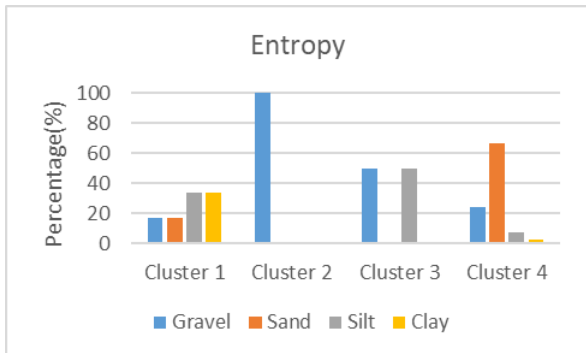
Figure 8: Per cluster sediment composition percentage for GLCM Correlation texture layer